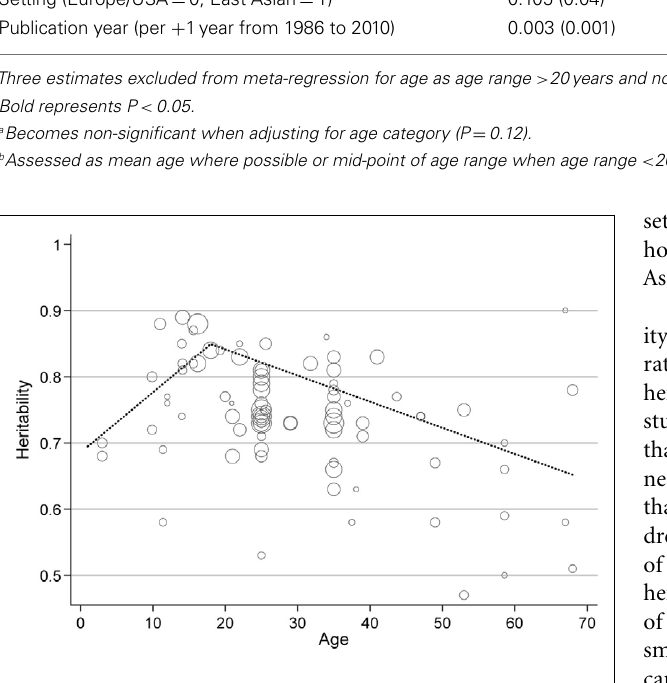
FIGURE 3 | Predicted BMI heritability by age. The dotted line represents predicted BMI heritability by age, modeled using piecewise linear splines with a knot point at age 18 to separate childhood and adulthood.The figure shows that the relative contribution of genetic factors to variation in BMI increases over childhood before declining during adult life. Each circle represents an individual estimate of BMI heritability, and the size of the circle is proportional to the inverse of the SE of the heritability estimate. Age is based on the mean age of the study sample, or the mid-point of the age range where this was not